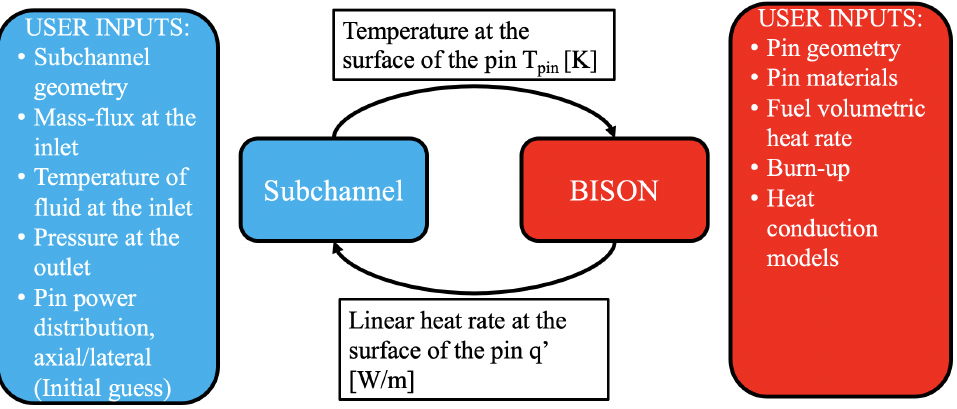
Figure 4. Data transfer between Subchannel and